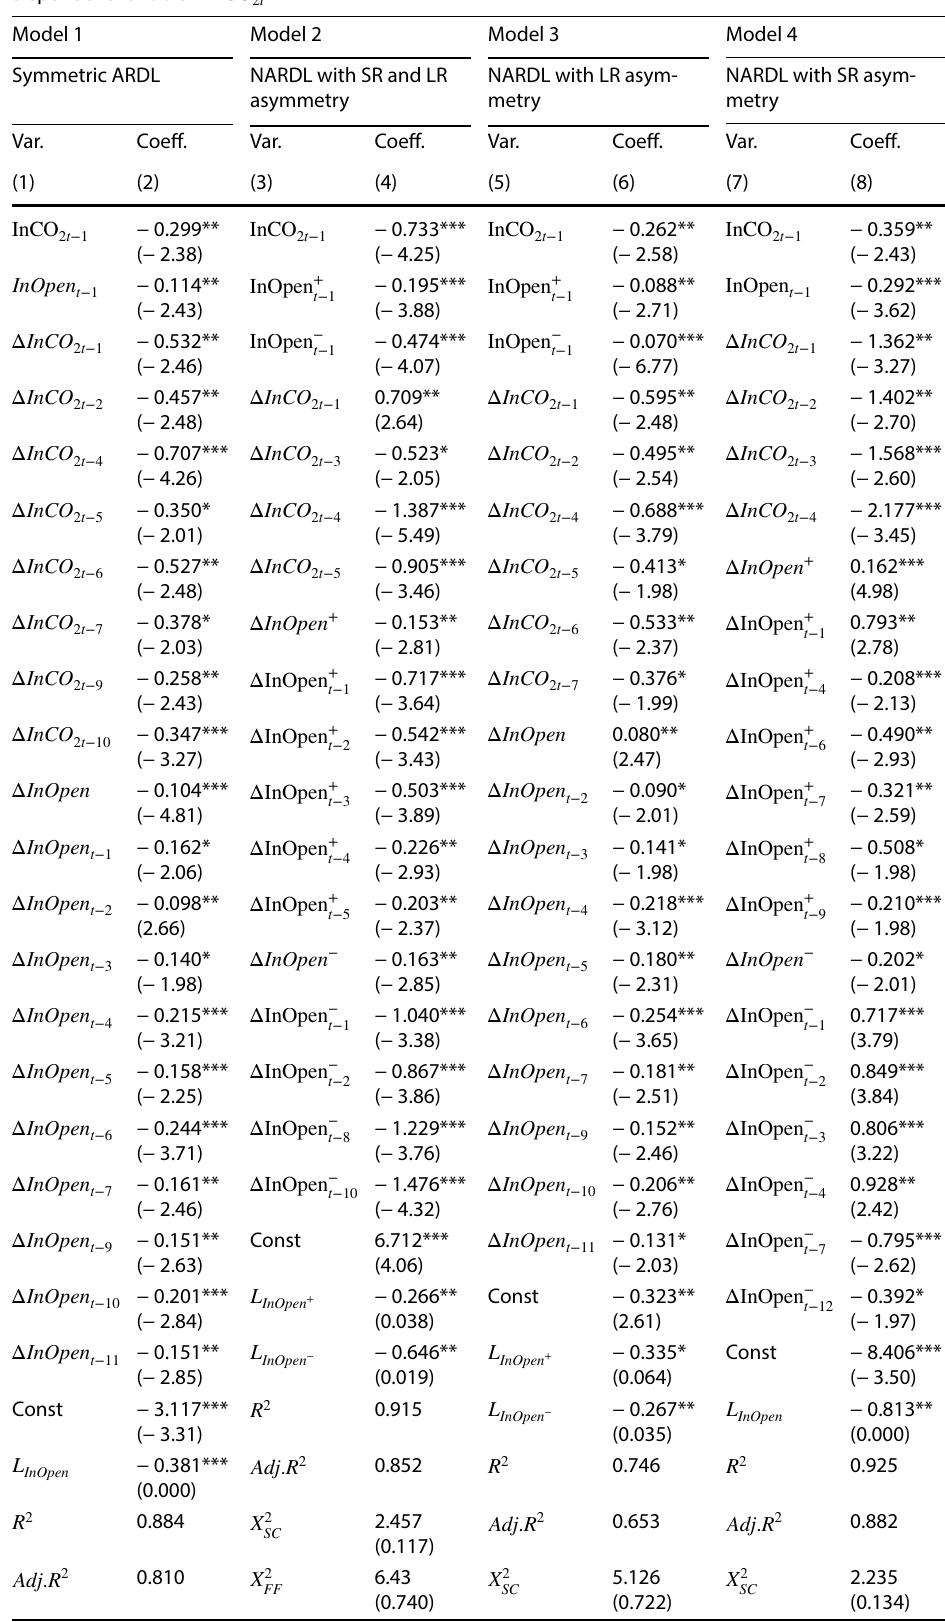
Table 17 Full-information estimates of both symmetric ARDL and nonlinear ARDL (NARDL) models in